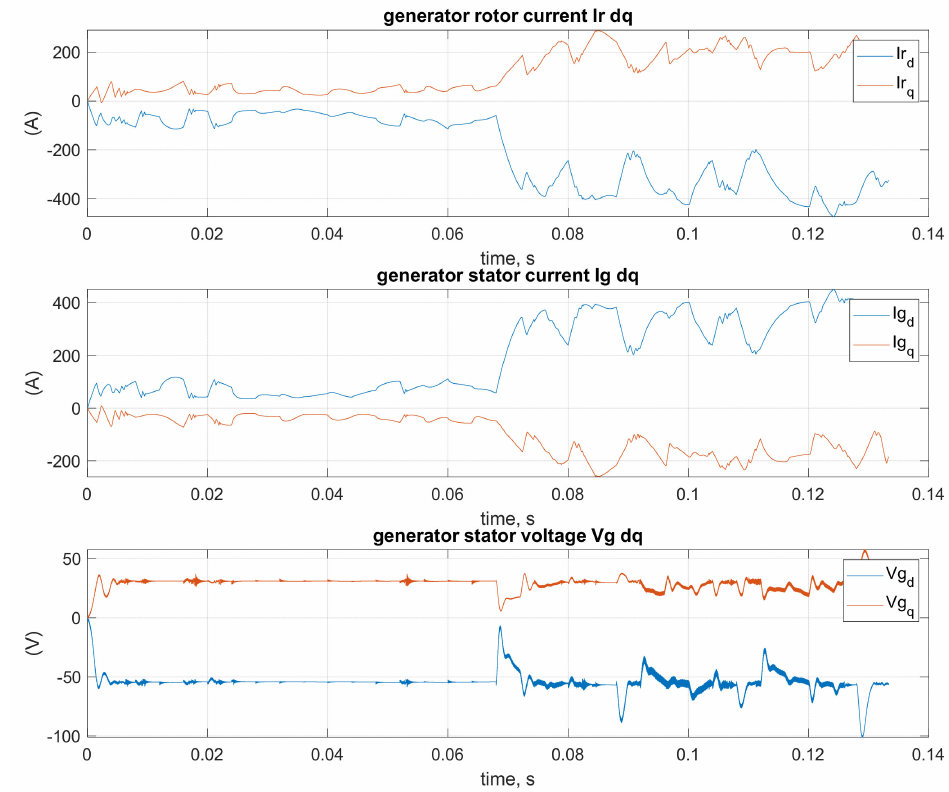
Figure 15. Stator voltage V g , stator current I g and rotor current I r in the dq coordinate system, with no limitations on the rotor current I r but with limitations on the rotor voltage V r under increasing load conditions as in Figure